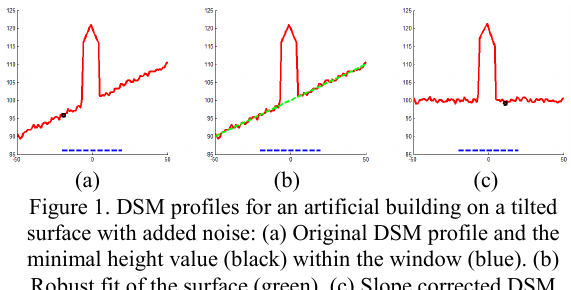
Figure 1. DSM profiles for an artificial building on a tilted surface with added noise: (a) Original DSM profile and the minimal height value (black) within the window (blue). (b) Robust fit of the surface (green). (c) Slope corrected DSM profile and the according minimal height value.